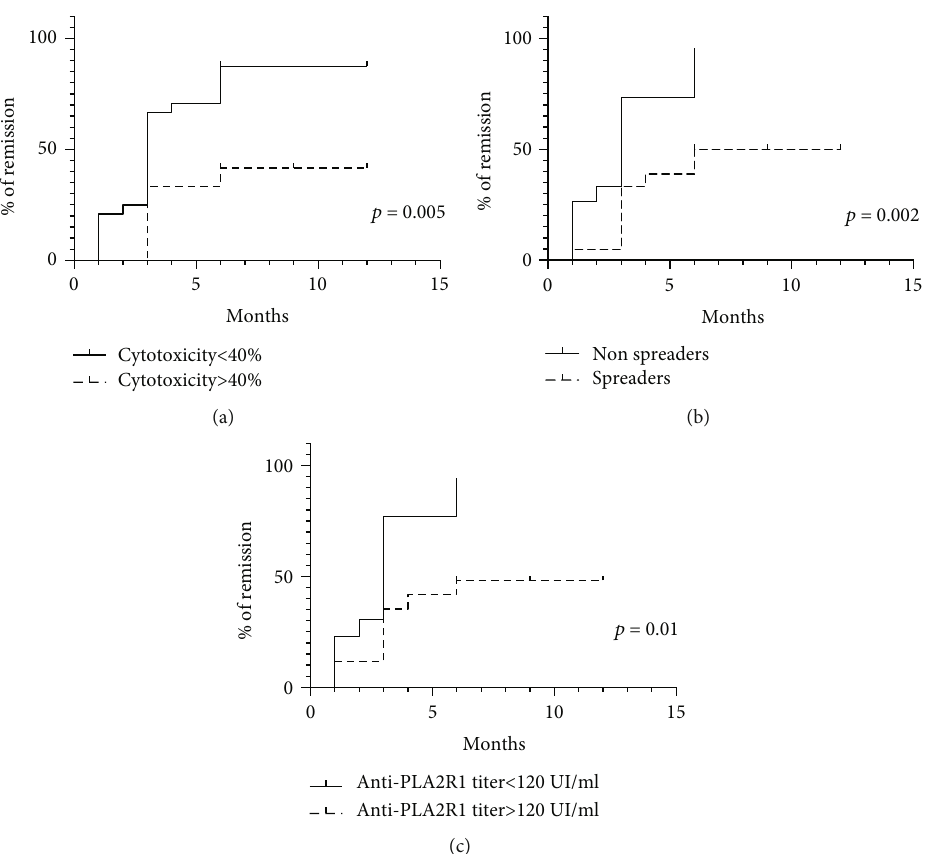
Figure 4: Factors associated with remission. Renal event is de fi ned by remission (partial or complete) one year after diagnosis of MN. (a) Percent of patients achieving remission according to the level of complement-mediated cytotoxicity ( n = 37 ). (b) Percent of patients achieving remission according to epitope spreading pro fi le ( n = 37 ). (c) Percent of patients achieving remission according to the level of total IgG anti-PLA2R1 ( n = 37